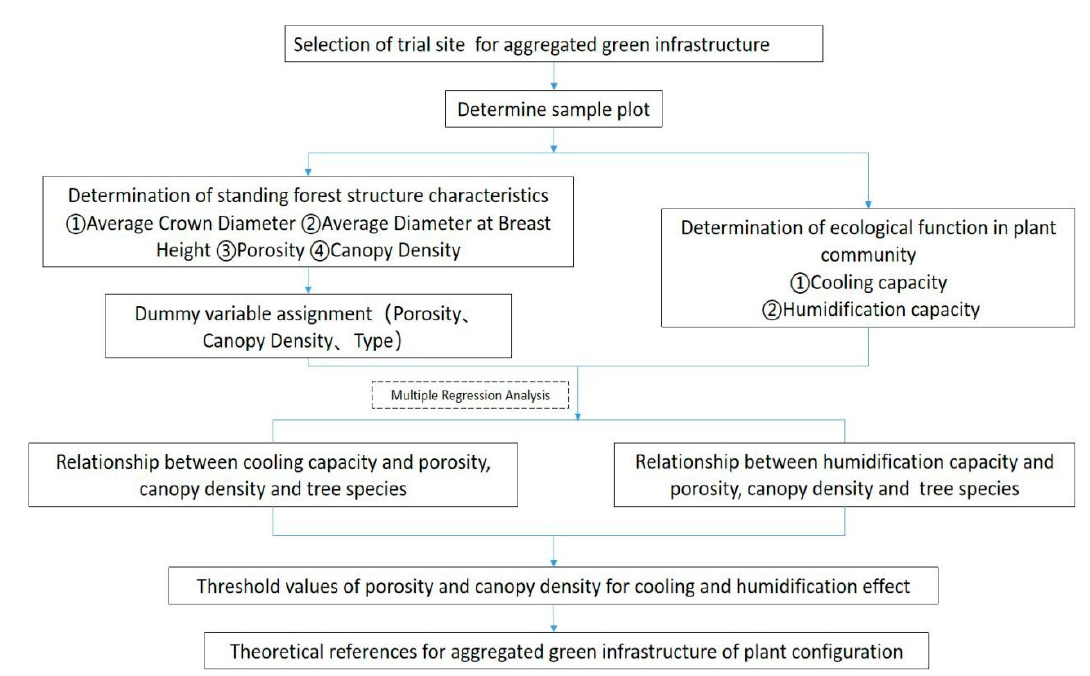
Figure 1. Experimental method step diagram.